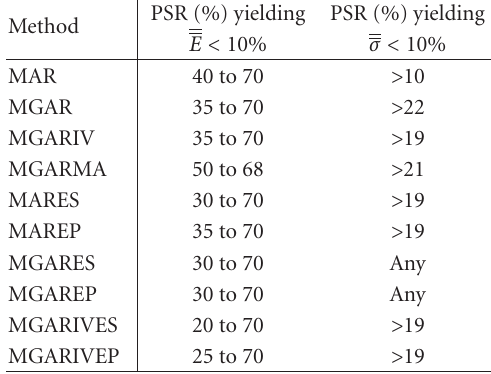
Figure 4: Test 1: 95% confidence bands for Prony-based methods, mode 1.